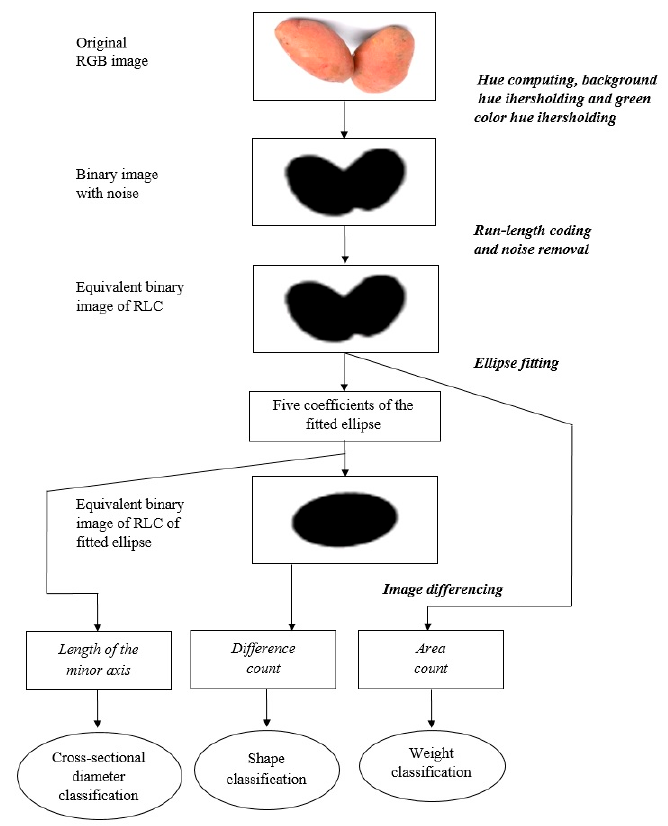
Figure 6. Flowchart of potato tuber sorting and image recognition process. The diameter of the cross-section of the potato tuber determines the size requirement when sorting potatoes. It is defined as the largest dimension perpendicular to the longitudinal axis.